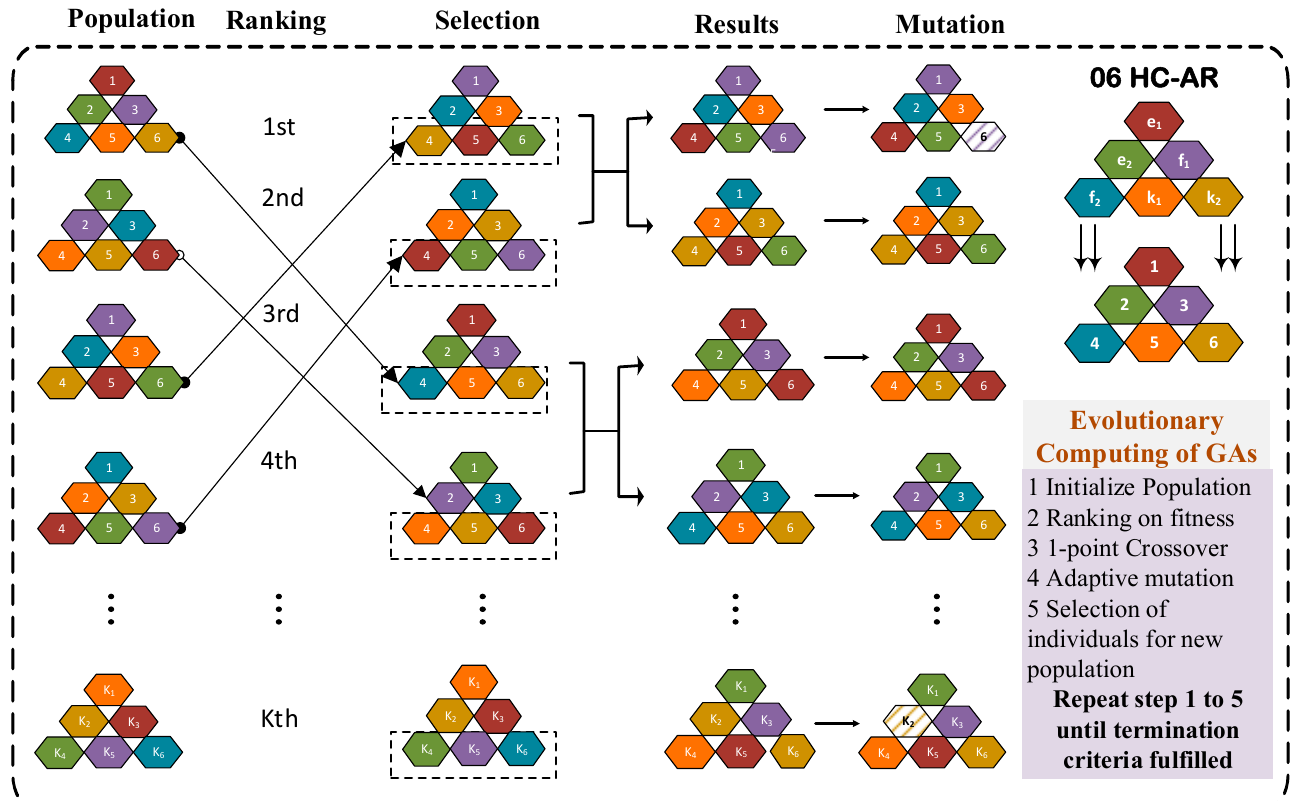
Figure 2. Overview of reproduction operators of GAs representing HC-AR systems.